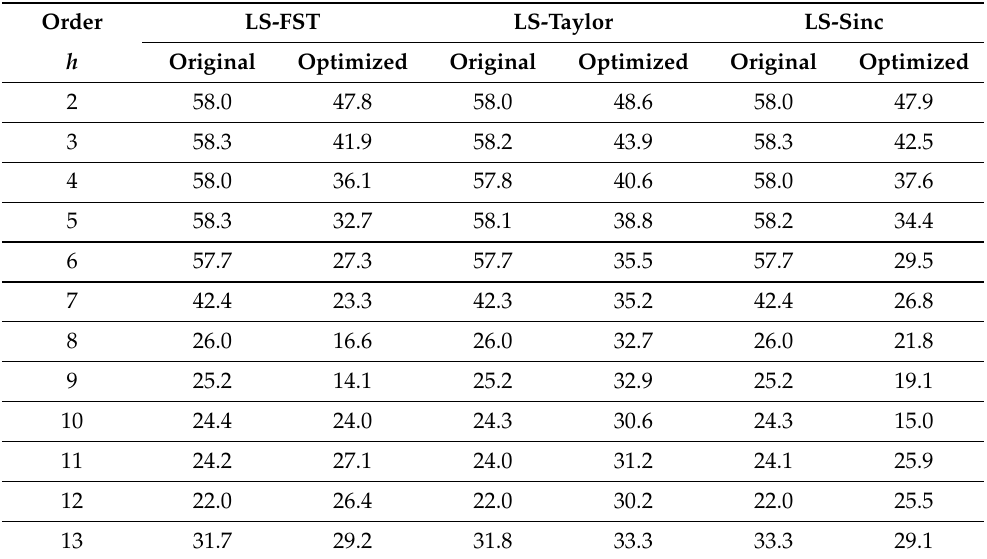
Table 2. The response times of the LS-FST, LS-Taylor, and LS-Sinc with and without the proposed optimization under harmonic amplitude step test.